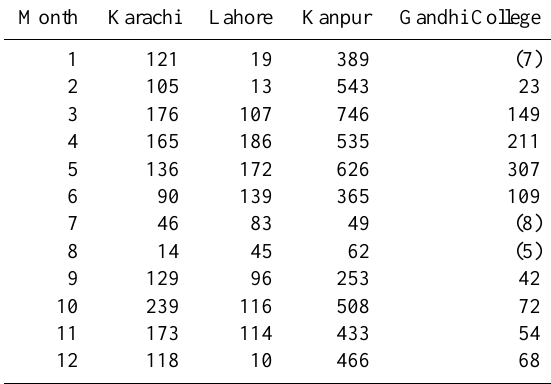
Table 2. Number of AERONET observations for each month for the four sites. Data were collected for Karachi from September 2006 to August 2011, for Lahore from April 2007 to October 2011, for Kanpur from January 2001 to April 2012, and for Gandhi College from April 2006 to March 2010. Monthly data in parentheses were not included in the study due to the low number of